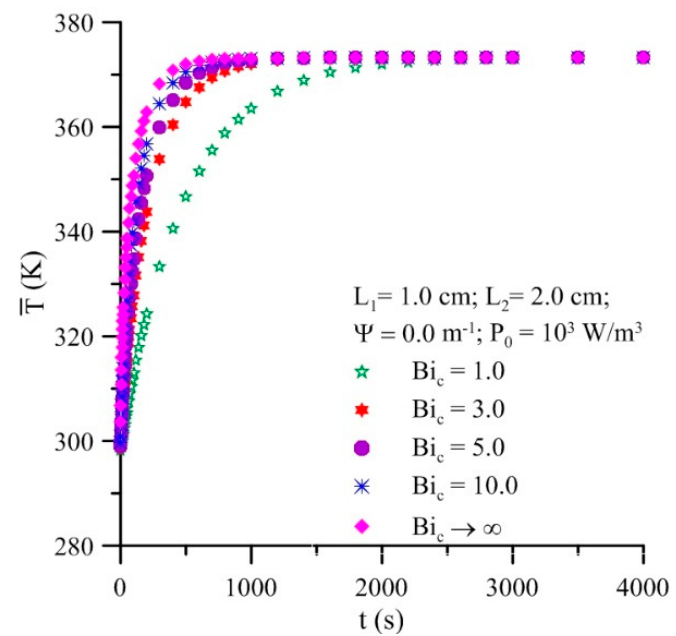
Figure 6. Transient behavior of the average moisture content in a prolate spheroidal solid with aspect ratio 2.0, different mass transfer Biot numbers and fixed microwave power density.